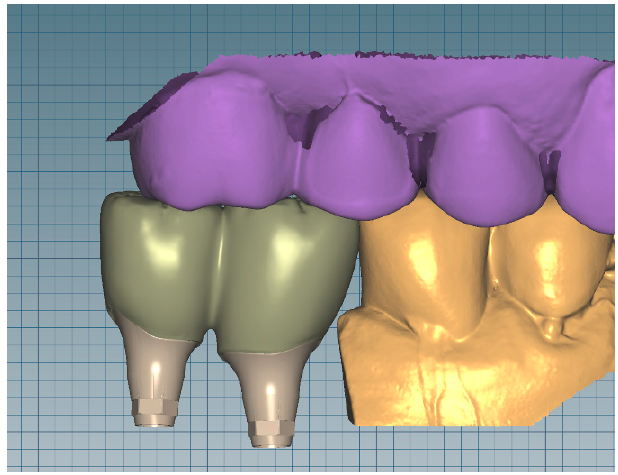
Figure 1. Design of the monotype custom prosthetic abutments and interim prosthesis.